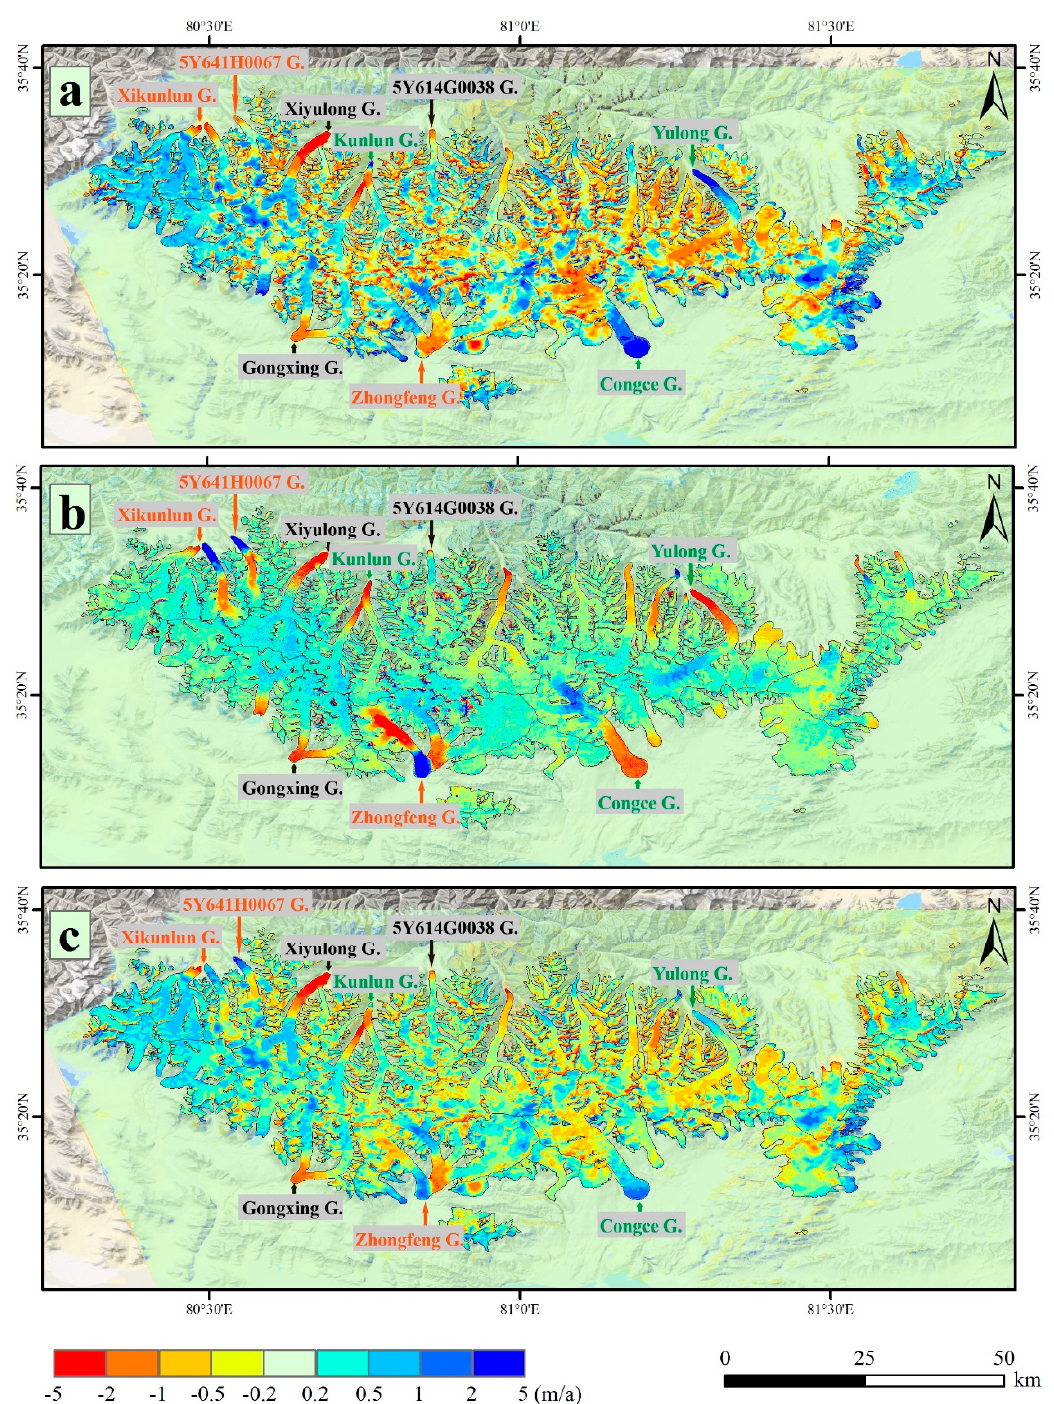
Figure 4. Changes in glacier surface elevation over time periods: ( a ) 1970–2000; ( b ) 2000–2016 and ( c ) 1970–2016. The names of the glaciers are presented in the text.